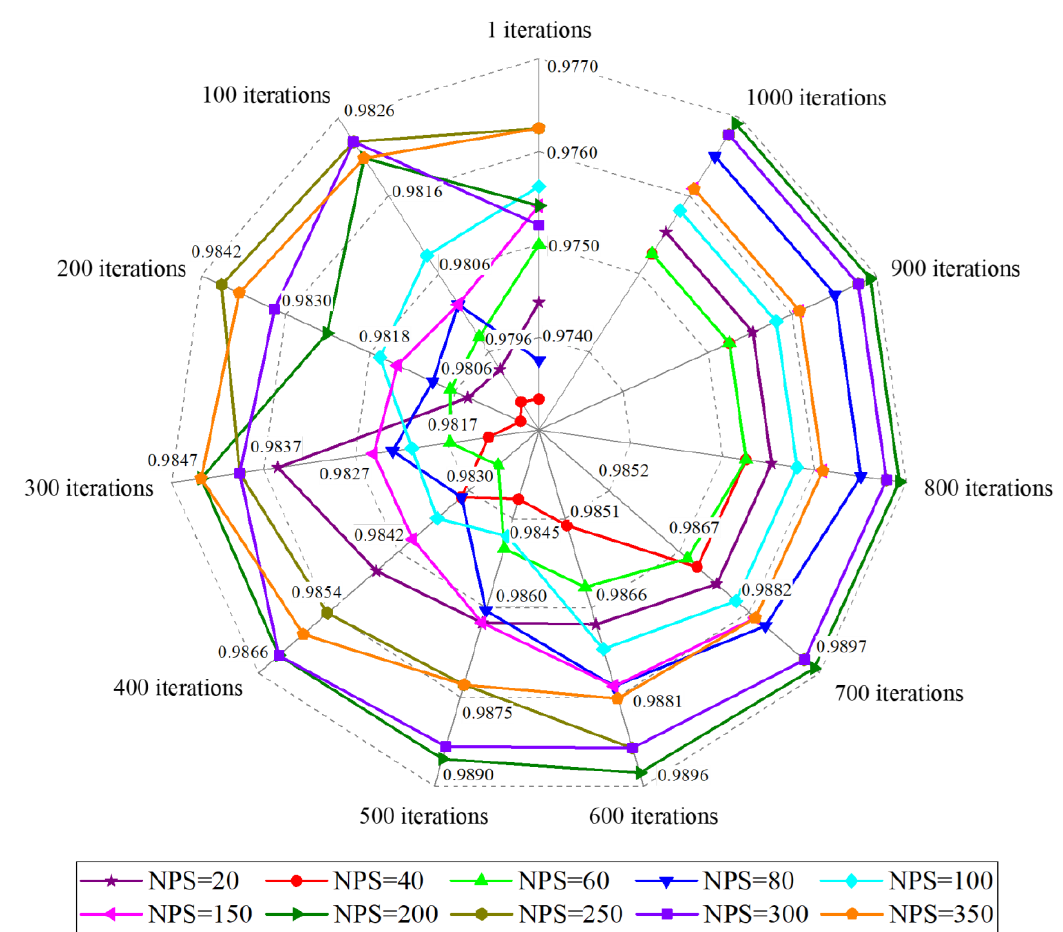
Figure 10. Accuracy curves of 10 PSO-ELM models with 1000 iterations and various NPS.